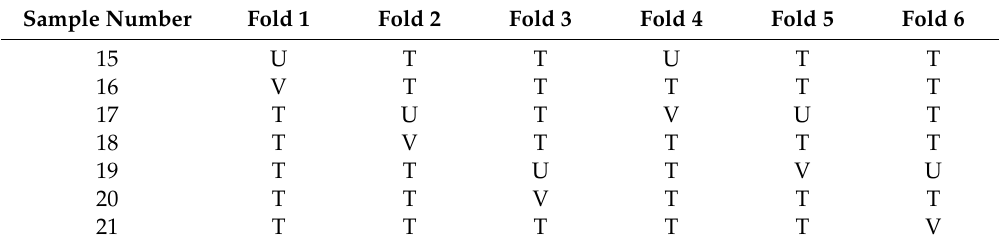
Table 2. Distribution of samples from class 3 182 HB for T—training subset, U—testing subset, and V—validating subset, for the cross-validation